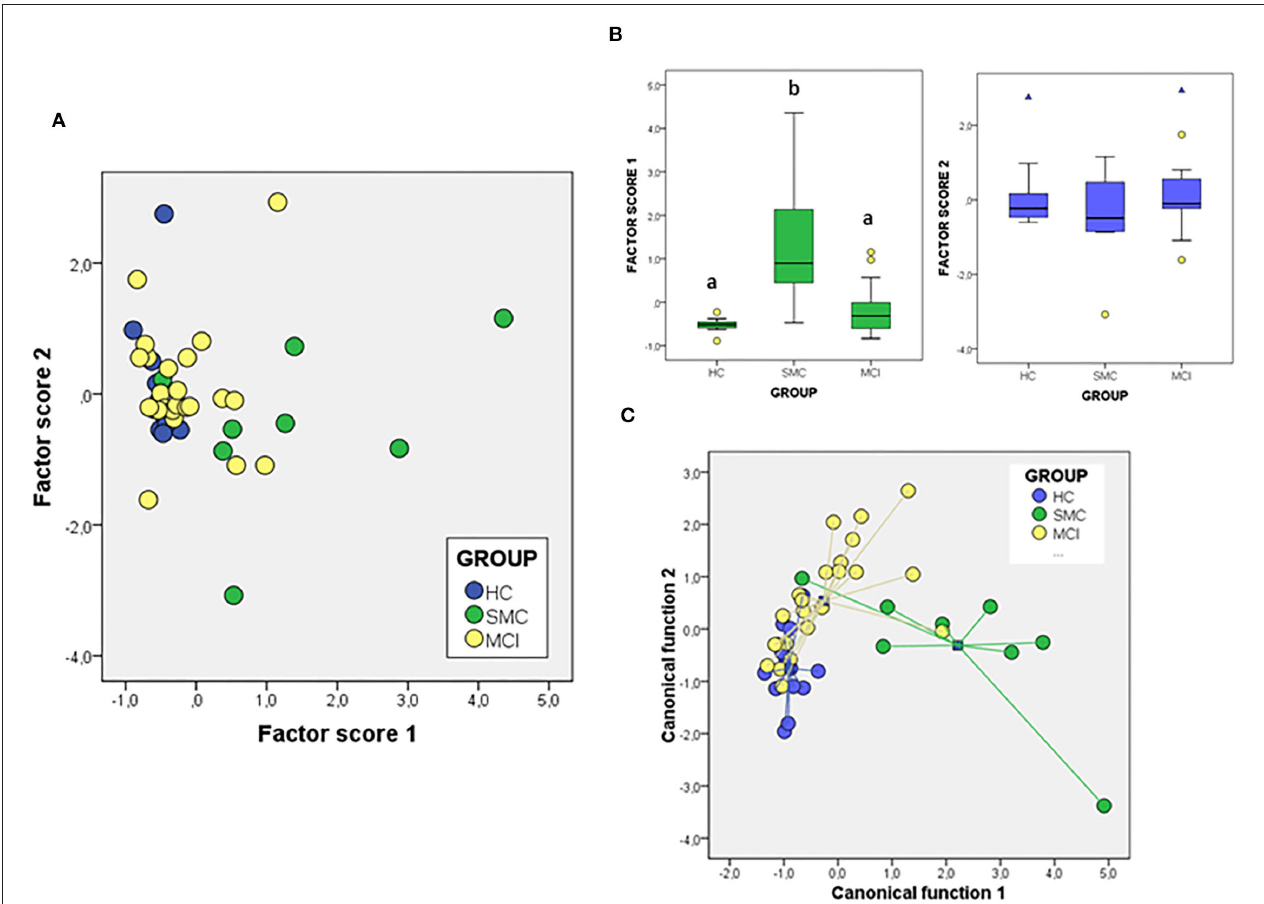
FIGURE 6 | The PCA (A,B) and DFA (C) of signalosome protein ratios in the CSF of subjects from HC, SMC, and MCI groups. Factor scores in plot (B) were submitted to one-way ANOVA followed by post-hoc Tukey’s HSD test. The different letters indicate statistically significant differences with p <